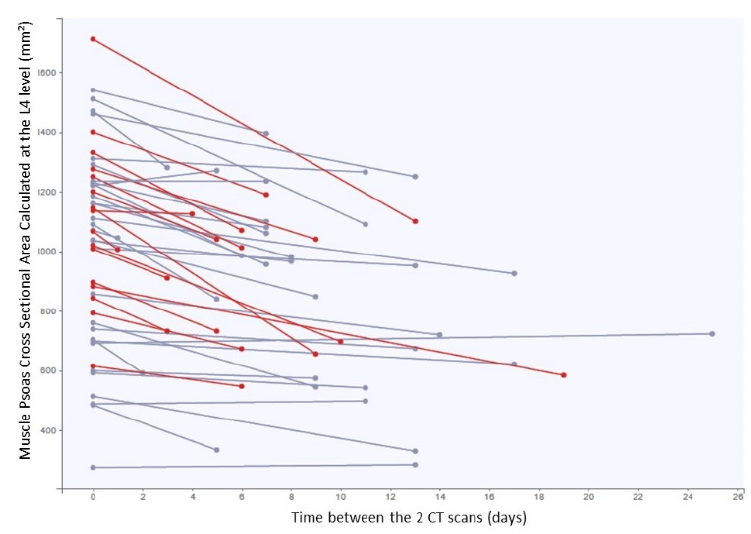
Figure A1. Evolution of muscle psoas CSA over time between ARC vs. non-ARC patients.